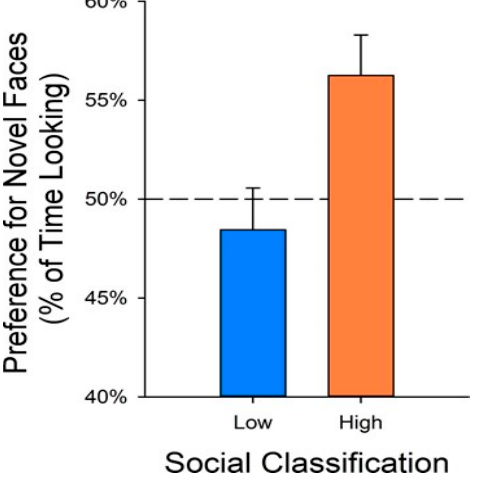
Figure 2. Novelty preference and social classification. Animals identified as highly social were more likely to detect novel from familiar faces in the memory task. Reprinted from [40] . likely to detect novel from familiar faces in the memory task. Reprinted from